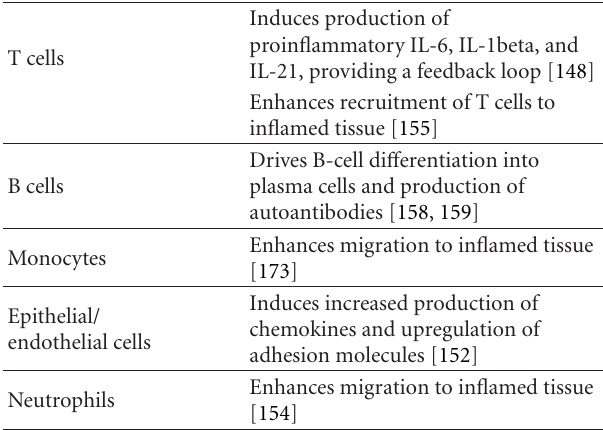
Table 1: IL-17 exerts e ff ects on several cell types and